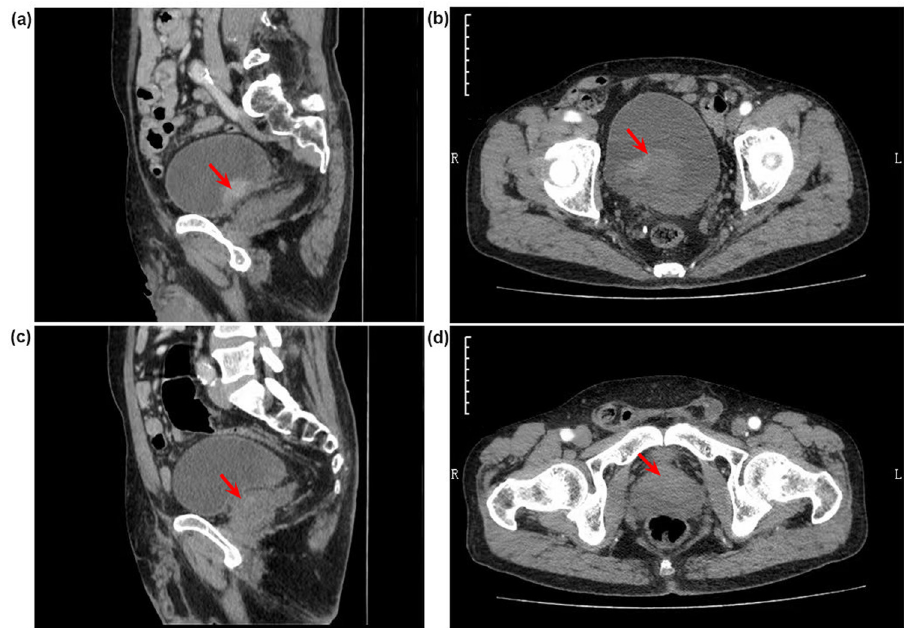
Figure 1: CT scan of the pelvic cavity in August 2020. ( a and b ) Show the bladder carcinoma: a soft tissue mass ( about 38 mm × 23 mm ) with a wide base was seen in the bladder triangle, and the mass was uniformly enhanced in contrast CT. The bladder wall shown with limited thickening and sti ff ness. ( c and d ) Show the prostate carcinoma: The prostate was enlarged ( about 52 mm × 43 mm ) with uniform density. ( a and c ) belongs to the sagittal position. ( b and d ) belongs to the axial